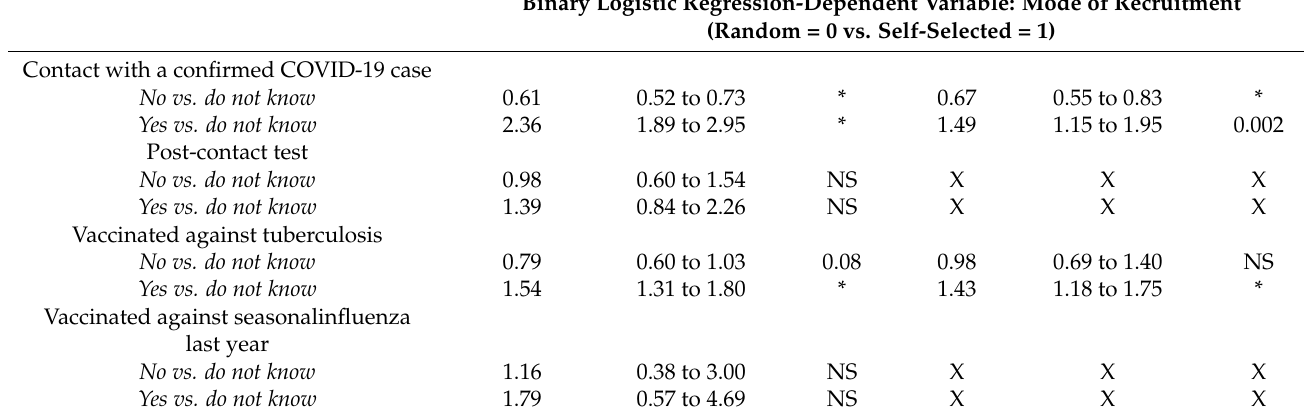
Table 5. Cont . Binary Logistic Regression-Dependent Variable: Mode of Recruitment (Random = 0 vs. Self-Selected =